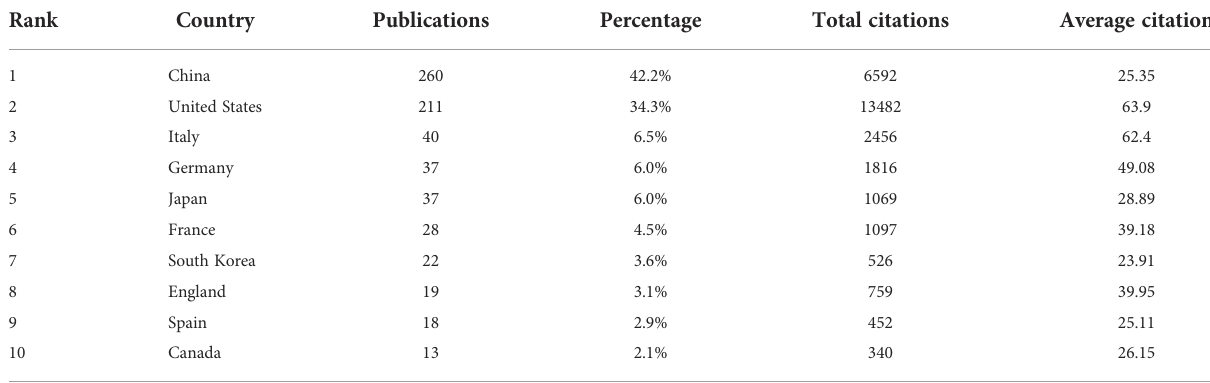
TABLE 1 The top 10 productive countries in the fi eld of autophagy and pancreatic cancer. Rank